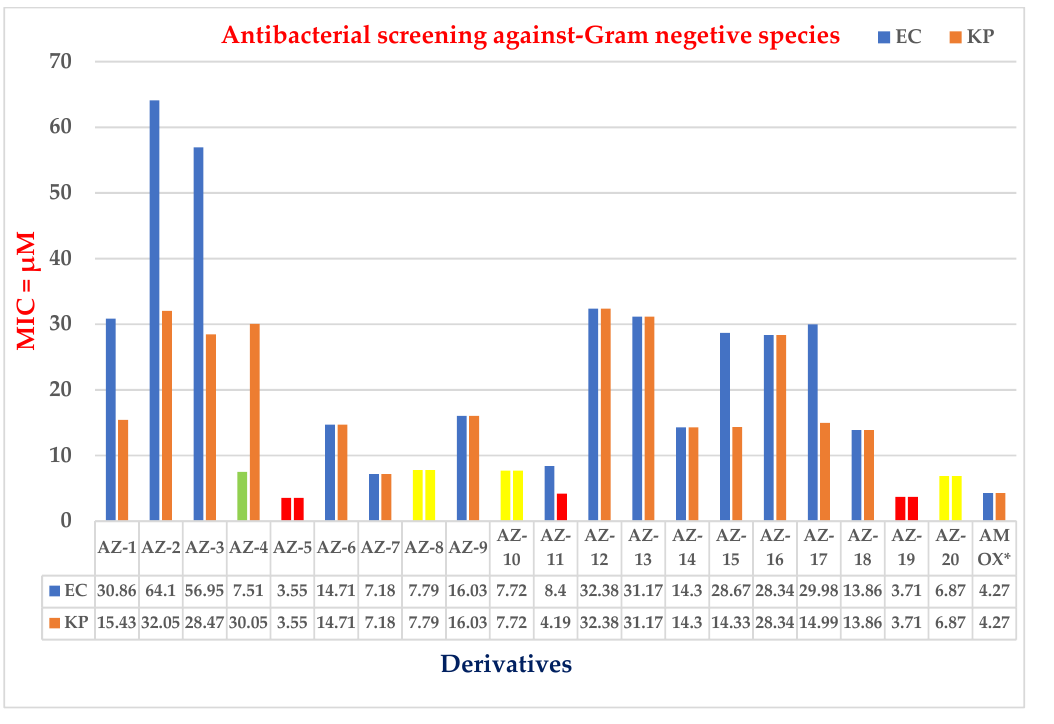
Figure 4. Antibacterial screening against-Gram negative species of synthesized derivatives. *-Standard drug.